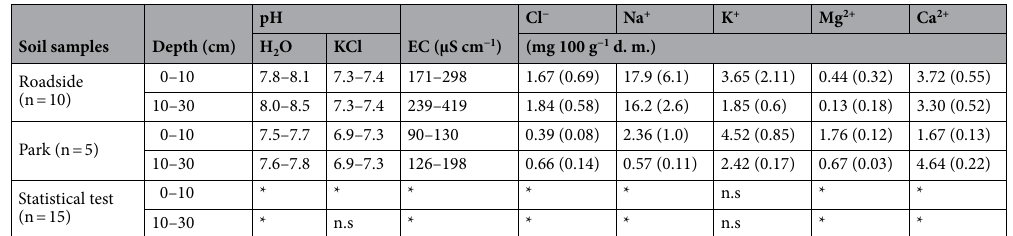
Table 2. The pH indicator, conductivity (EC), chloride and cation concentrations in soils. Values are: min– max (pH, EC), median, and IQR in parentheses (Cl, Na, K, Mg, Ca). *p < 0.001 significant difference between roadside and park samples (Mann–Whitney U test).